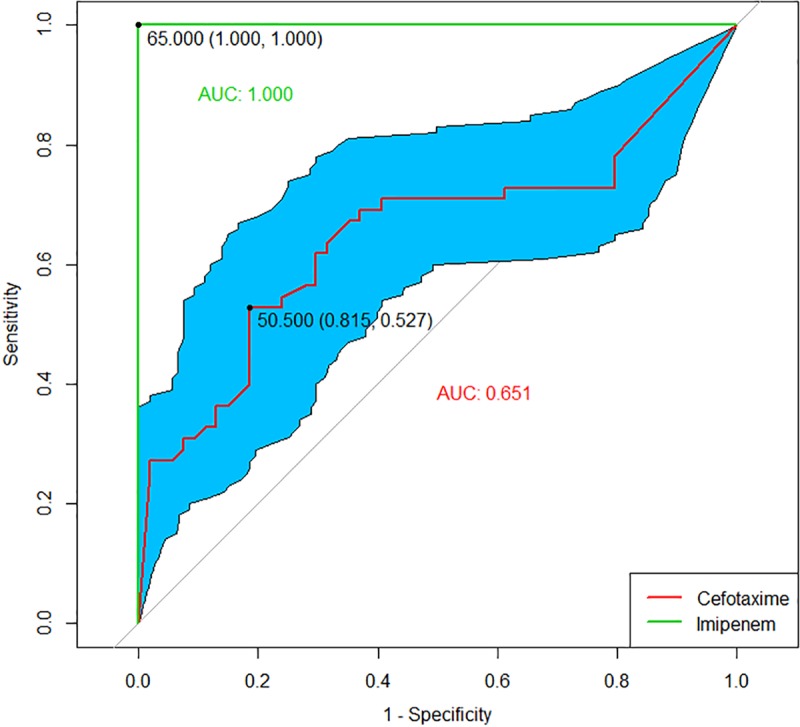
ROC analysis of imipenem (green) and cefotaxime (red).AUC: area under the curve.